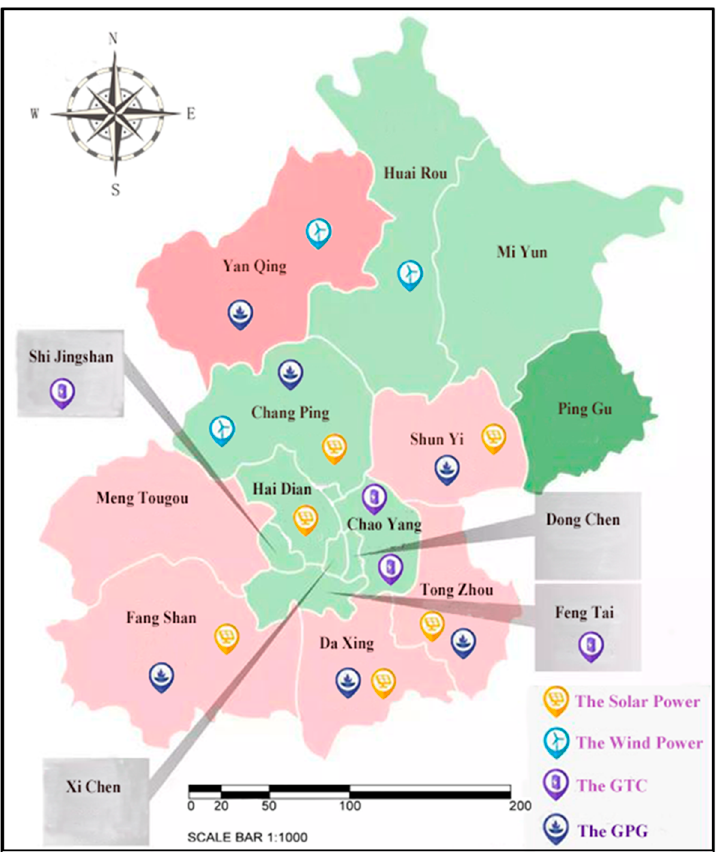
Figure 1. The distribution of the Beijing’s electric power resource (the GTC is the gas thermoelectric power center; the GPG is the geothermal power generation).